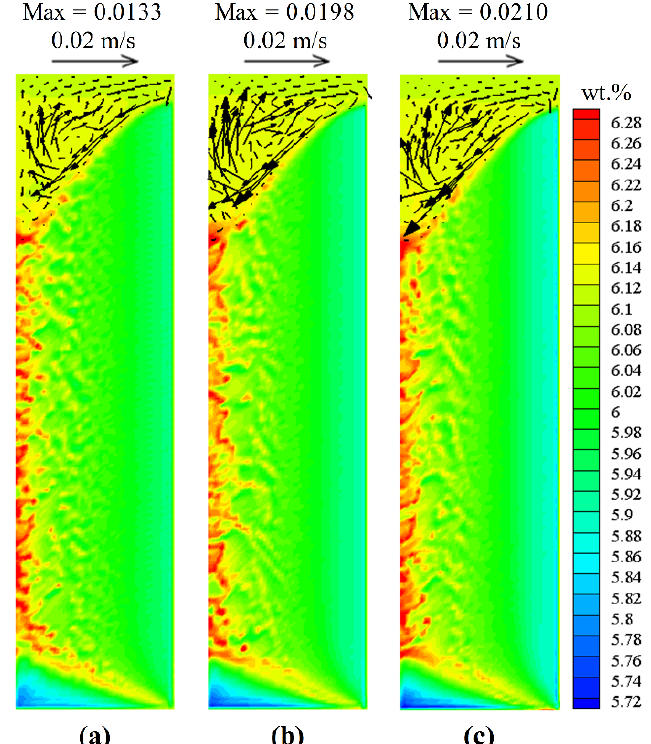
Figure 11. Macrosegregation maps predicted in the non-grain-refined billet with different casting temperatures of ( a ) 920 K (case 5), ( b ) 943.35 K (case 2), and ( c ) 970 K (case 6) when the maximum height is reached.